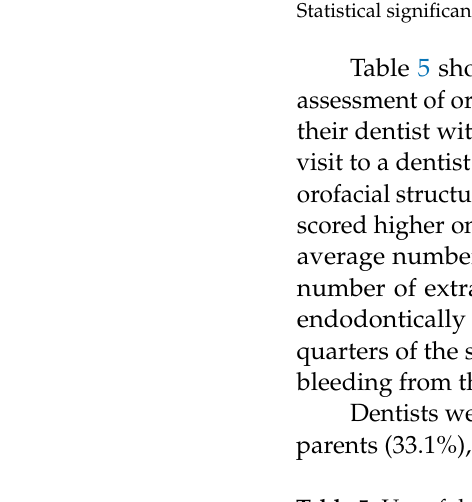
Table 5. Use of dental services and self-assessment of oral health among students according to the average assessment of knowledge about oral